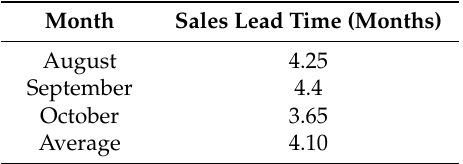
Table 5. The sales lead time (August 2015 to October 2015). Month Sales Lead Time